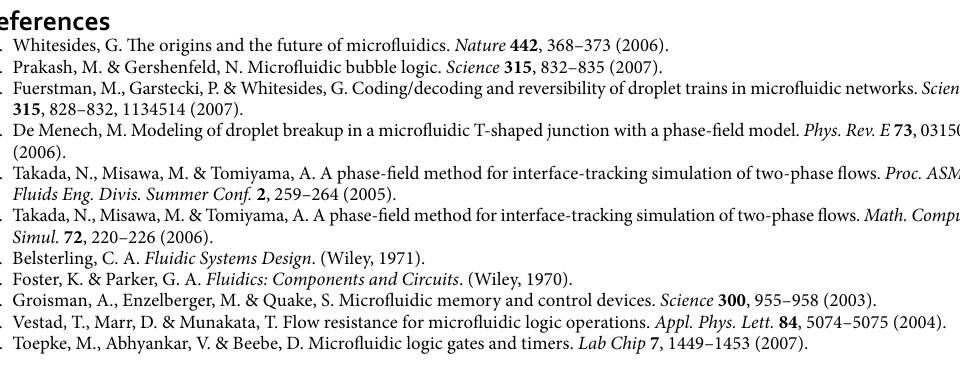
Table 7 illustrates the simulation detail of each logic gate, wherein t in is average time the first bubble forms, tout is average time the first bubble reaches the outlet, L is bubble length, and (cid:31) is average distance between two bubbles.